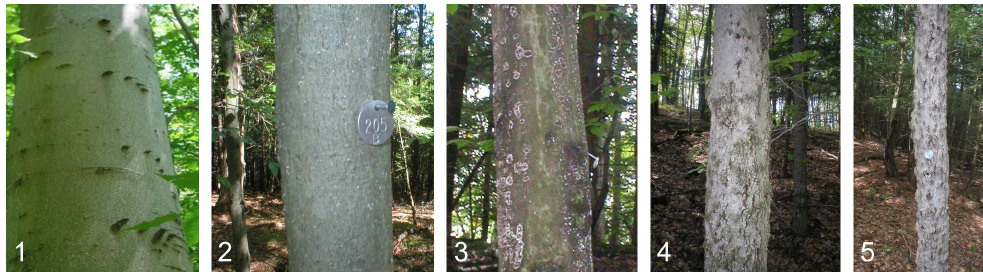
Figure 1. Healthy beech trees ( 1 ) are becoming increasingly rare in the United States. During the initial infection stage of BBD ( 2 ), Beech have small patches of white (sign of the overwintering beech scale) that can eventually become quite large. Holes left by the boring insects are then colonized by nectria fungi, showing characteristic rusty welts ( 3 , 4 ). Eventually, the tree is killed by BBD ( 5 ). Note that both bark and canopy conditions influence the field rankings of BBD (despite these photos only showing bark). Photos taken by Natalie Coe and Robin